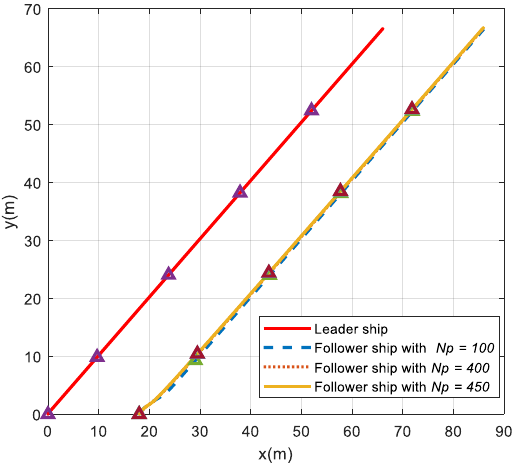
Figure 5. The tracking of performance of the synchronization control with disparate prediction horizon.